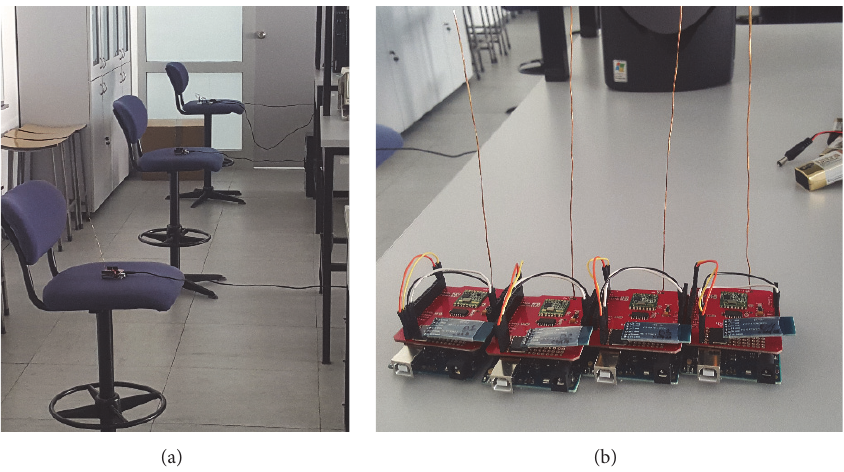
Figure 12: Implementation of demo scenario, (a) positions of three readers, and (b) tags carried by people.